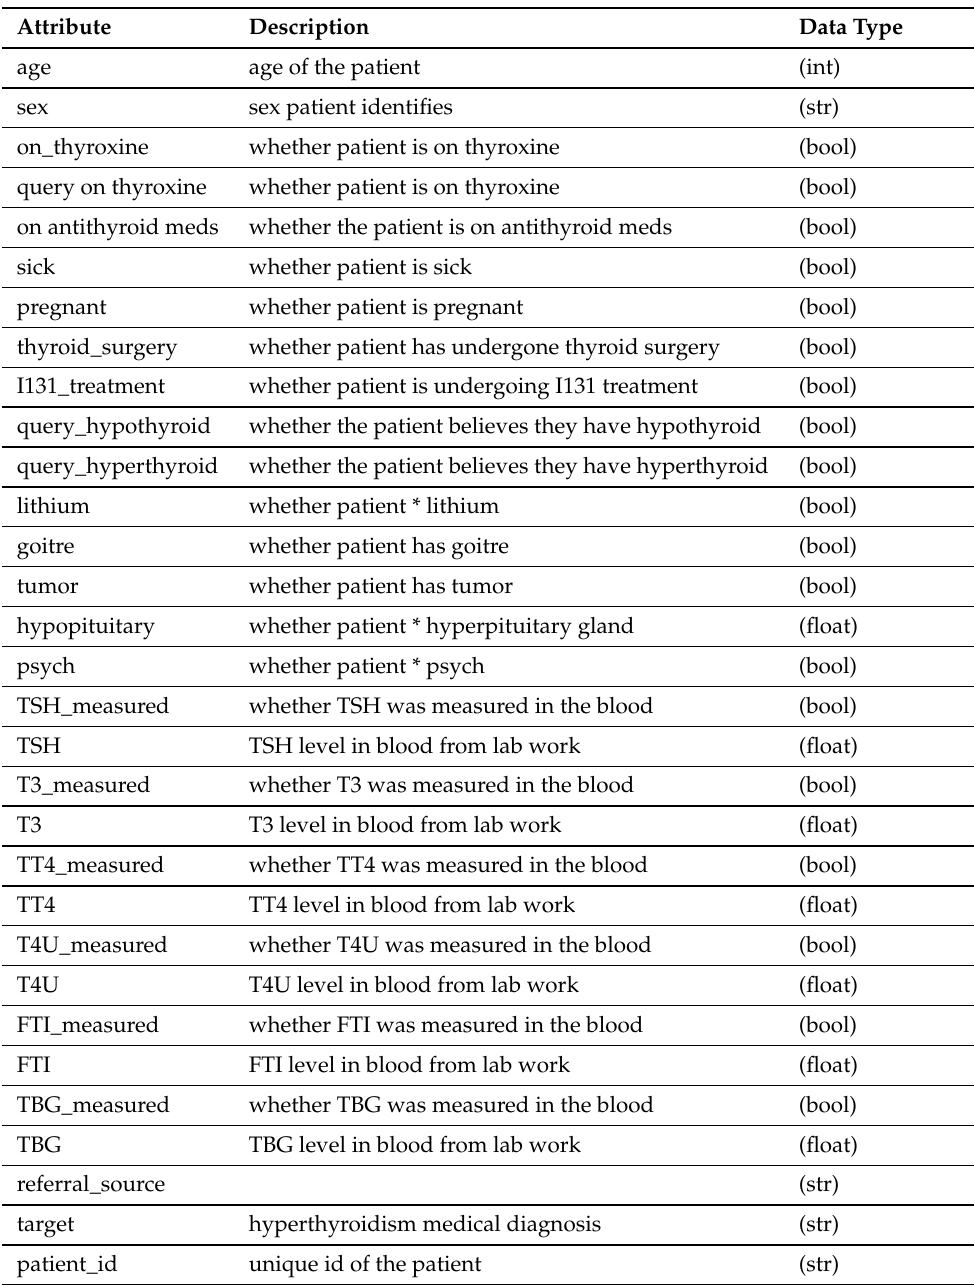
Table 3. Data sample attribute